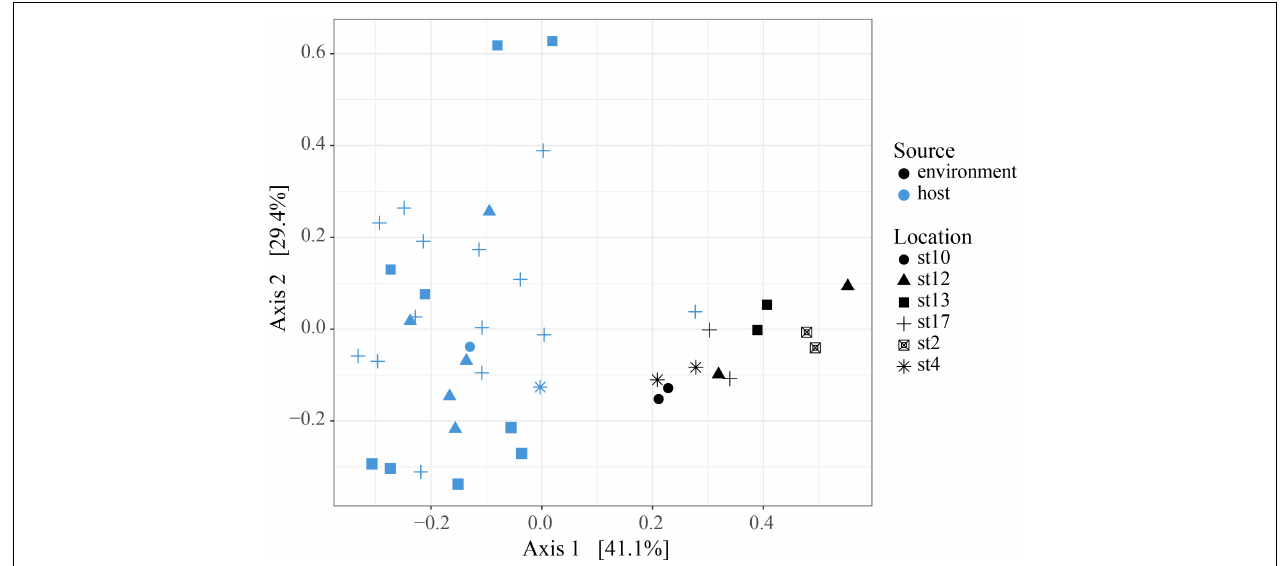
FIGURE 5 | Principal Coordinates Analysis of Bray-Curtis distances between host-associated symbiont communities and free-living symbiont communities. PCoA plot from Bray-Curtis distances between ECS environmental free-living and the host-associated symbiotic community compositions, including all symbiotic SVs identified in this study. The two sample types cluster separately and the difference in community composition is statistically significant (PERMANOVA, p = 0.001, R 2 = 0.326, 999 permutations). Analyses were performed with R packages phyloseq and vegan and plot was rendered with R package